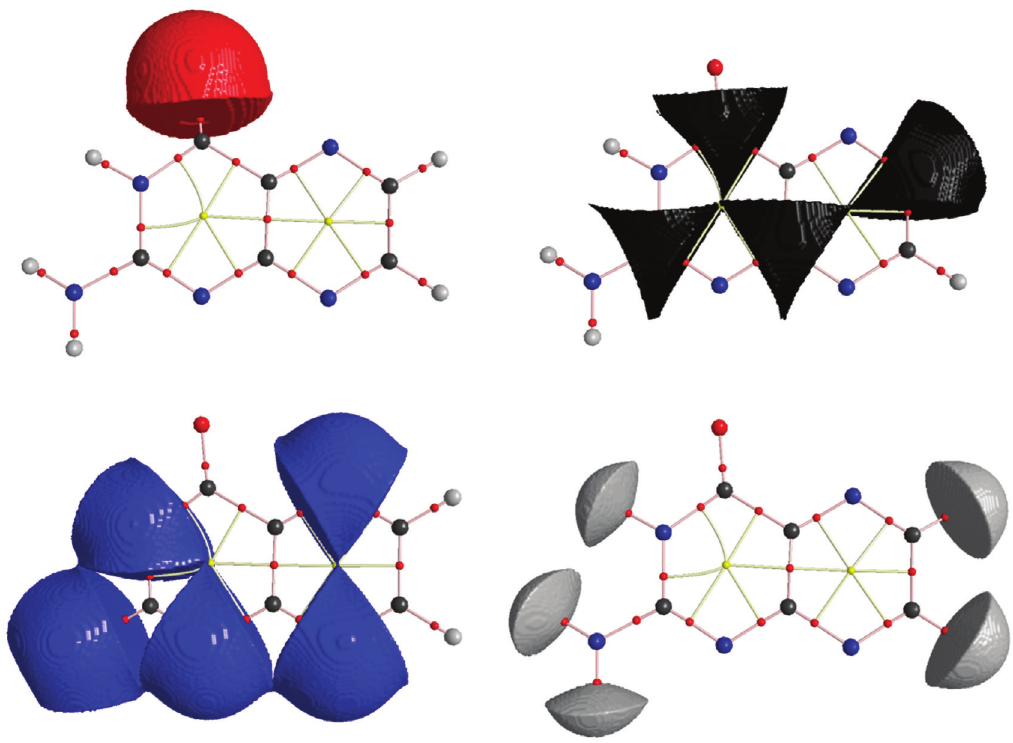
Figure 2 Molecular graph for neutral pterin and visualizations of selected atomic basins of attraction of oxygen (left top; red), nitrogens (left bottom; blue), carbons (right top; black) and hydrogens (right bottom; light grey). For clarity, only selected carbons are